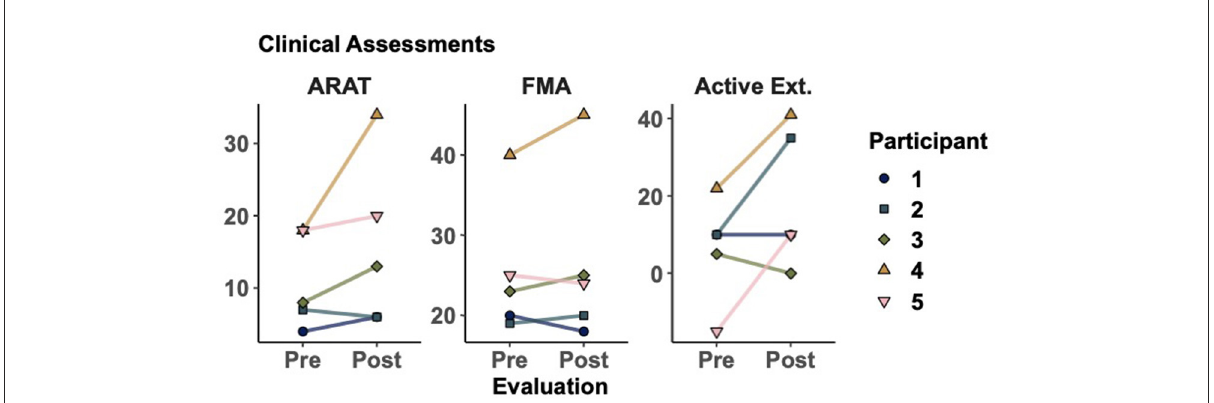
FIGURE2 Clinical assessments before and after training. Markers represent the score for each participant as evaluated in sessions 1 and 32. Action research arm test (ARAT), Fugl-Meyer assessment of the upper extremity (FMA), active range of motion during wrist extension. Additional results can be seen in Table